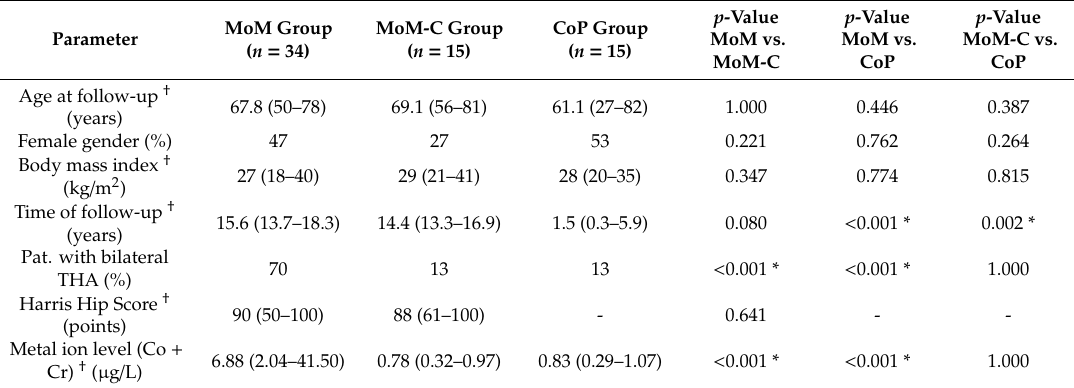
Table 2. Demographic data of the metal-on-metal study group (MoM, n = 34), the metal-on-metal control group (MoM-C, n = 15) and the ceramic-on-polyethylene group (CoP, n =